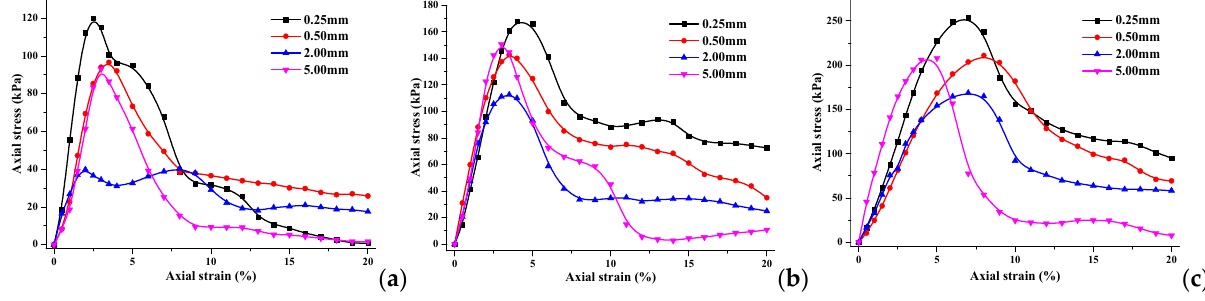
Figure 8. Stress–strain curve of red clay: ( a ) 1.3 g/cm 3 ; ( b ) 1.4 g/cm 3 ; ( c ) 1.5 g/cm 3 . Furthermore, by comparing the angle formed by the peak point and the curve on both sides, it is easy to see that the greater the dry density, the greater the angle; this also indicates that the ability of the soil to withstand deformation before failure enhances with the increase in dry density. In addition, by comparing the residual strength values of damaged soil samples with the exact particle sizes but different dry densities (when the axial strain is 20%), a similar result is obtained that the dry density is proportional to the residual strength. The residual strength of the soil sample with a particle size of 5 mm is smaller than the residual strength of the soil sample with a particle size of 1.25–2 mm. The failure patterns displayed in Figure 7 show that after the shear failure, the friction force generated by the relative movement of the soil sample along the shear zone is smaller than the resistance of the soil mass after split failure when the soil particle is large. In addition, except for the one corresponding to 0.25 mm, the other curves at the dry density of 1.3 g/cm 3 follow the same rule, whereby the smaller the particle size, the greater the residual strength, which shows that the interaction force between the small particles is intensive. By defining the axial stress corresponding to the peak point of the stress–strain curve as the UCS of red clay, the curve of the relationship between the dry density and UCS of red clay with different particle sizes can be derived (Figure 9). The relationship between the particle size and the UCS of red clay at various dry densities is shown in Figure 10. According to these two figures, the greater the dry density, the greater the UCS of the red clay under different particle size conditions. Furthermore, as soil’s particle size increases, the red clay’s UCS first decreases and then increases under different dry density conditions. In Figure 9, at the same dry density, the UCS is most prominent at a particle size of 0.25 mm, smallest at a particle size of 2.0 mm, and closest at particle sizes of 0.5 mm, and 5 mm. The average UCS is 87.46 kPa for different particle sizes at a dry density of 1.3 g/cm 3 , increasing by 64.17% and 140.59% for dry densities of 1.4 g/cm 3 and 1.5 g/cm 3 , respectively. In Figure 10, the average UCS for different dry densities is 107.22 kPa at a particle size of 2.0 mm, increasing by 68.53%, 40.03%, and 40.42% at particle sizes of 0.25 mm, 0.5 mm, and 5.0 mm, respectively. The UCS is mainly related to the failure mode of the soil mass. Videlicet, when the soil particle size is smaller than 2.0 mm, the soil mass undergoes split failure. The larger the particle size, the smaller the UCS of the red clay. However, when the particle size of the soil is relatively large, the soil undergoes shear failure, and the UCS is mainly related to the friction between the particles, enhancing the strength of the soil. Hence, with the growth in particle size, the failure pattern of the soil mass changes from split failure to shear failure.